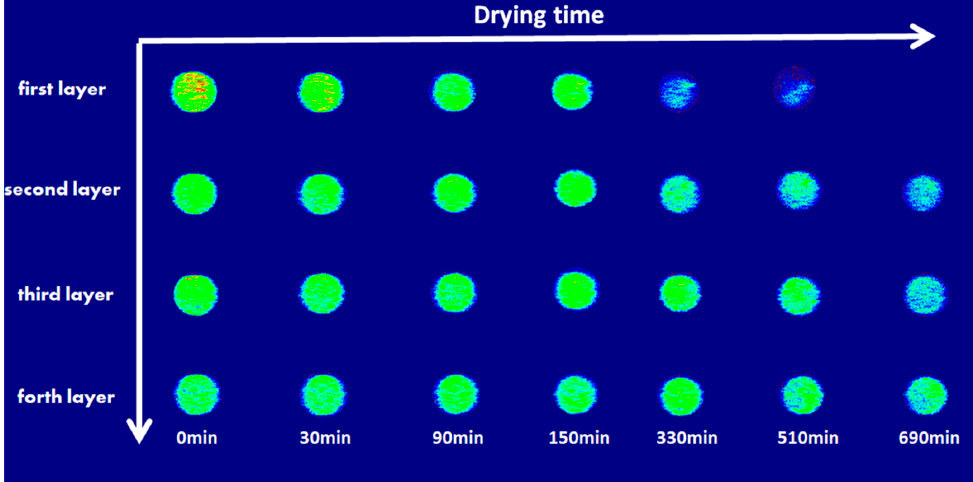
Figure 9. Images for the nuclear magnetic imaging of the Na 2 SO 4 solution sample at di ff erent drying times (the higher the brightness, the higher the water